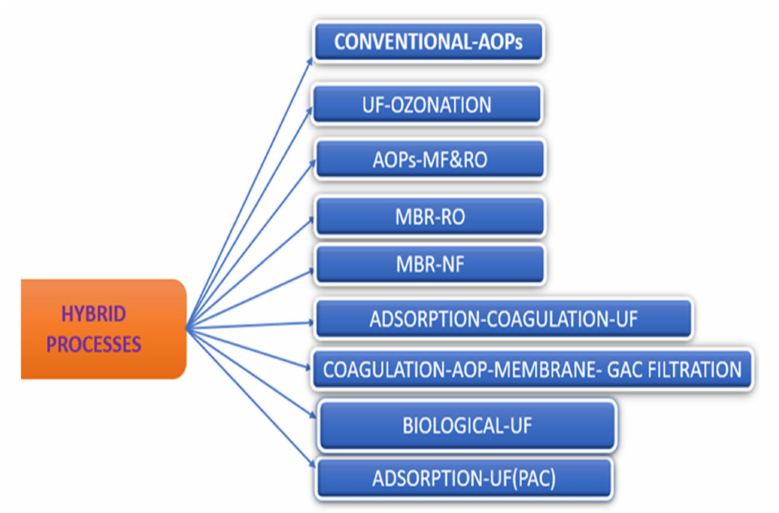
Figure 4. An overview of hybrid systems for the elimination of EDCs pollutants from various water